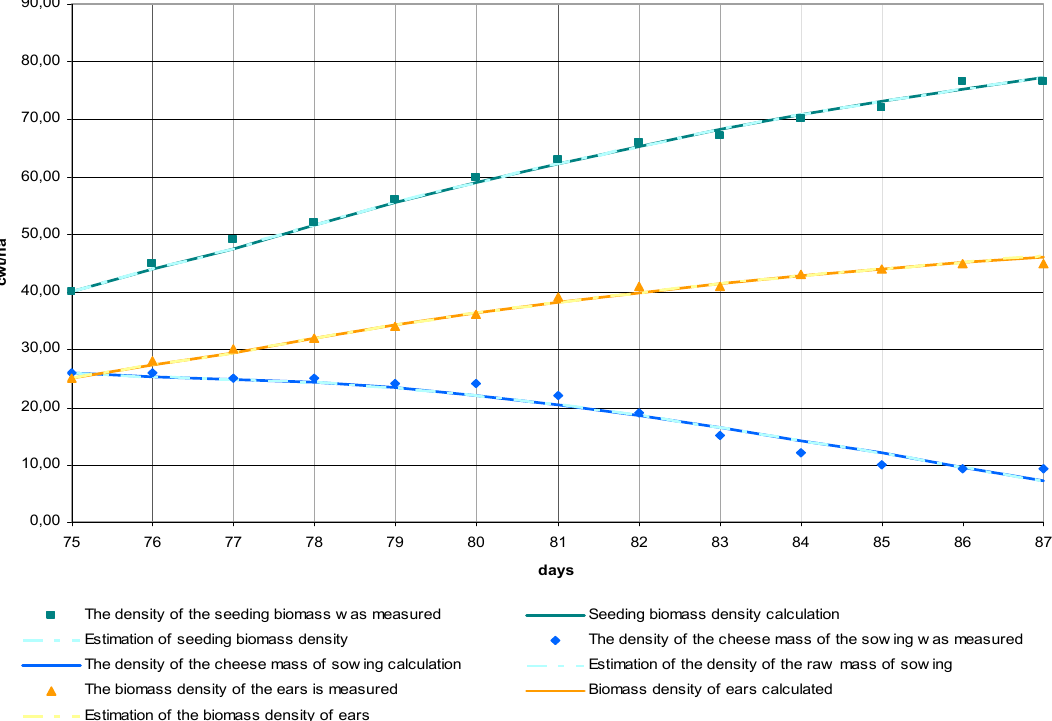
Figure 5. Estimates of the parameters of the biomass of spring wheat sowing in the time interval from heading to grain ripening.